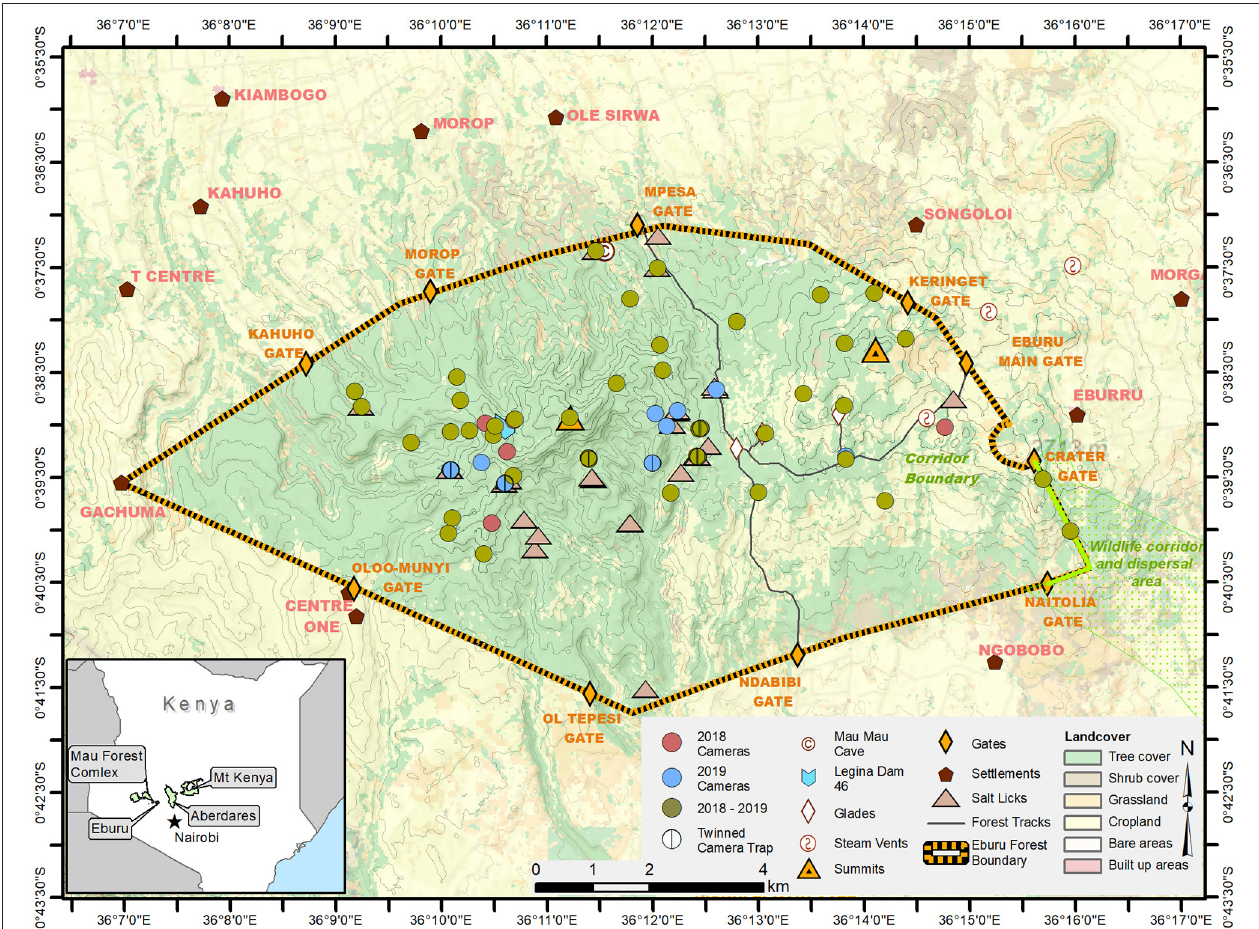
FIGURE 1 | Study area of Eburu National Forest, Kenya, and surrounding human settlements. Green, blue and mauve circles indicate the camera trap locations within the forest. The inset depicts Eburu’s location relative to the other forests where mountain bongos still remain in